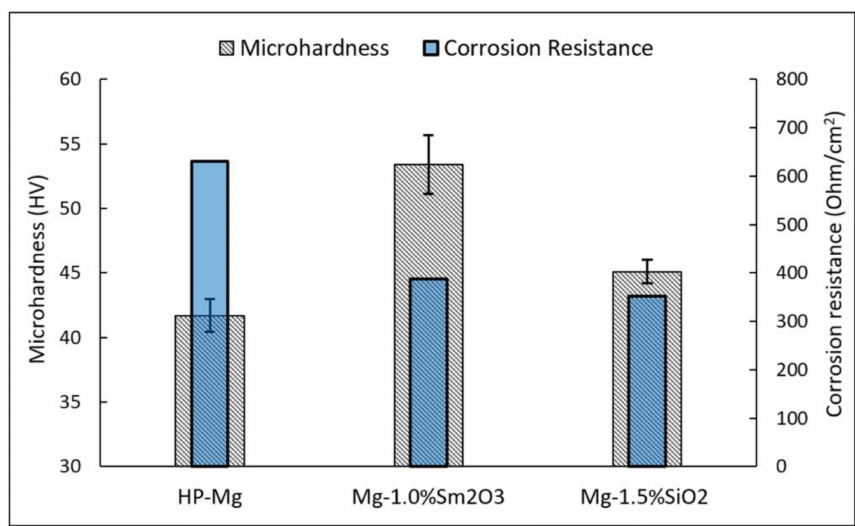
Figure 8. Comparison of the measured microhardness and corrosion rates of the Mg-1.0%Sm 2 O 3 and Mg-1.5%SiO 2 Nanocomposites compared to the HP-Mg